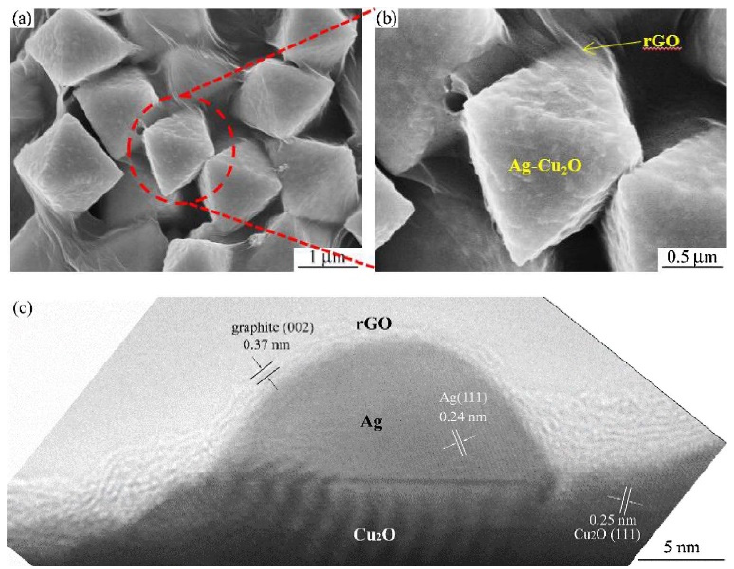
Figure 5. Microscopic images: ( a , b ) SEM, and ( c ) high resolution TEM of the Ag-Cu 2 O/rGO composite. Reprinted with permission from [41]. Copyright 2018 Elsevier.